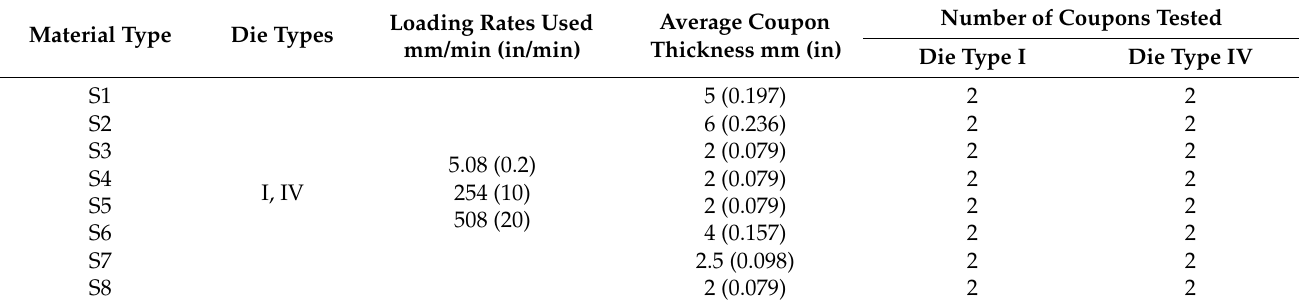
Table 3. Test matrix for the rate-dependent test.